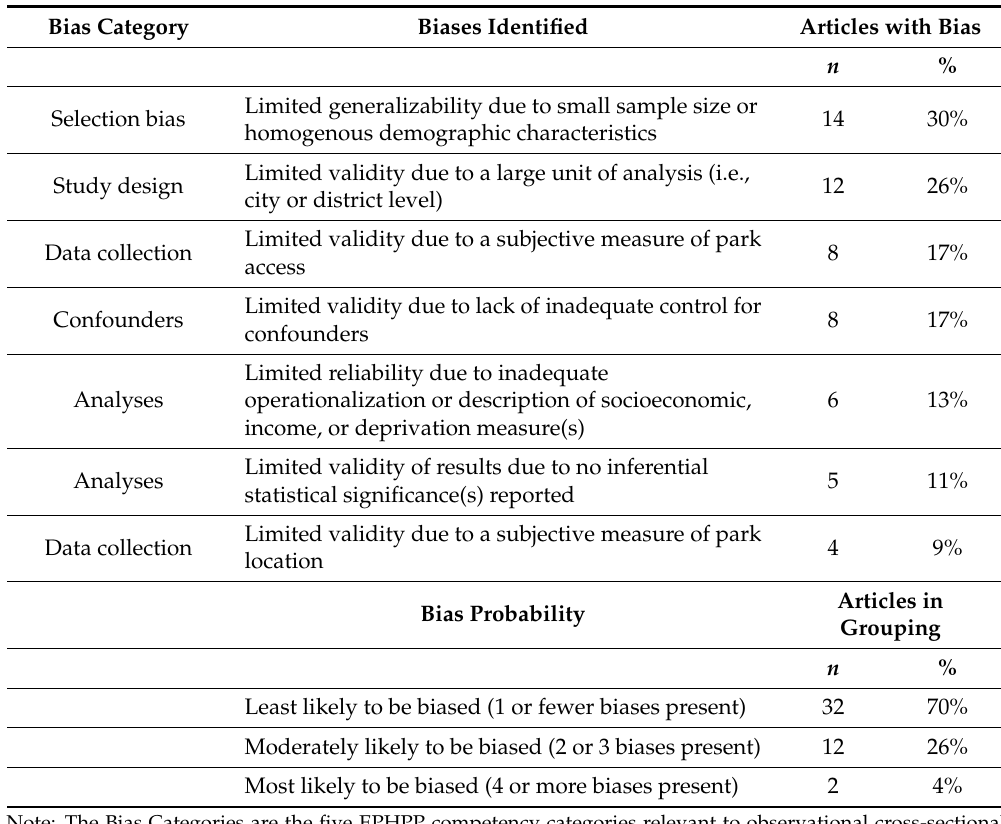
Table 3. Methodological biases in sampled